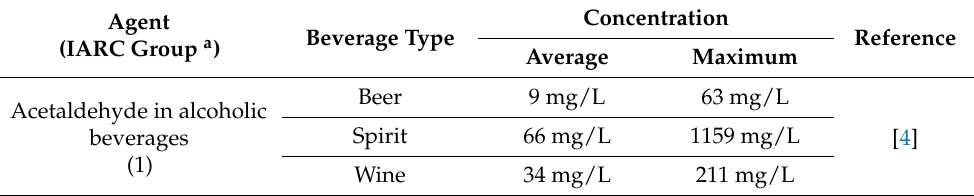
Table 1. Summary of the occurrence of potentially carcinogenic compounds in alcoholic beverages (reprinted with modifications with permission from Springer Nature, Archives of Toxicology, Pflaum et al. [1], copyright